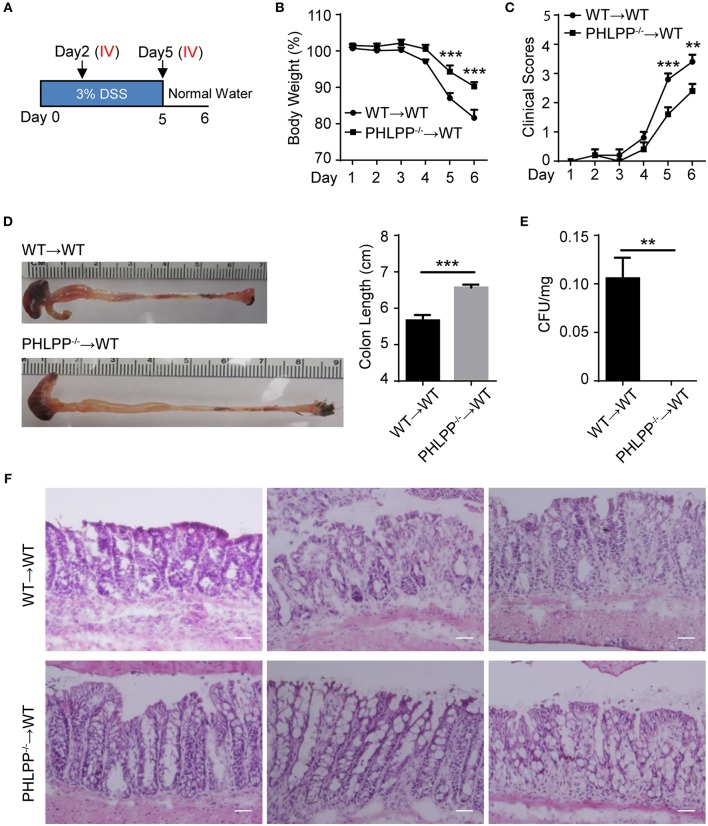
Adoptive transfer of PHLPP deficient neutrophils is sufficient to render protection against DSS-induced colitis. (A) Schematic drawing of the experimental design for the WT and PHLPP−/− neutrophil adoptive transfer in the DSS-induced acute colitis model. (B) Weight loss of WT or PHLPP−/− neutrophil recipients. n = 5 each group. (C) Clinical scores based on weight loss, physical body condition, stool consistency, and rectal bleeding. n = 5 each group. (D) Length of colon harvested from WT or PHLPP−/− neutrophil recipients. n = 5 each group. (E) Bacterial counts of spleen harvested from WT or PHLPP−/− neutrophil recipients. n = 5 each group. (F) H&E staining of colon tissues from WT or PHLPP−/− neutrophil recipients. Scale bar = 50 μm. **p < 0.01, ***p < 0.001.